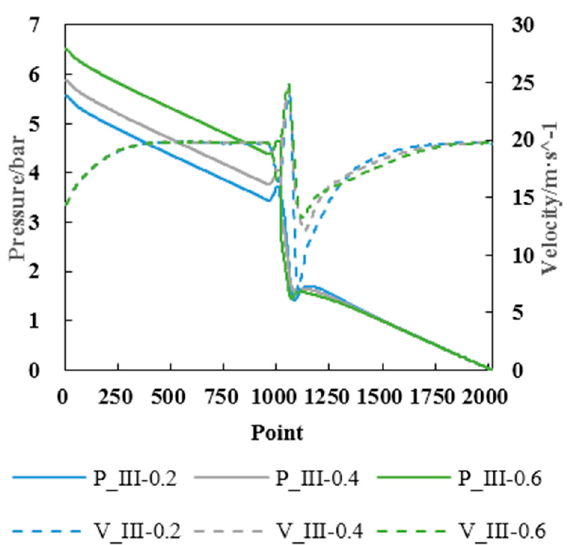
Figure 11. Pressure and velocity along passages III.